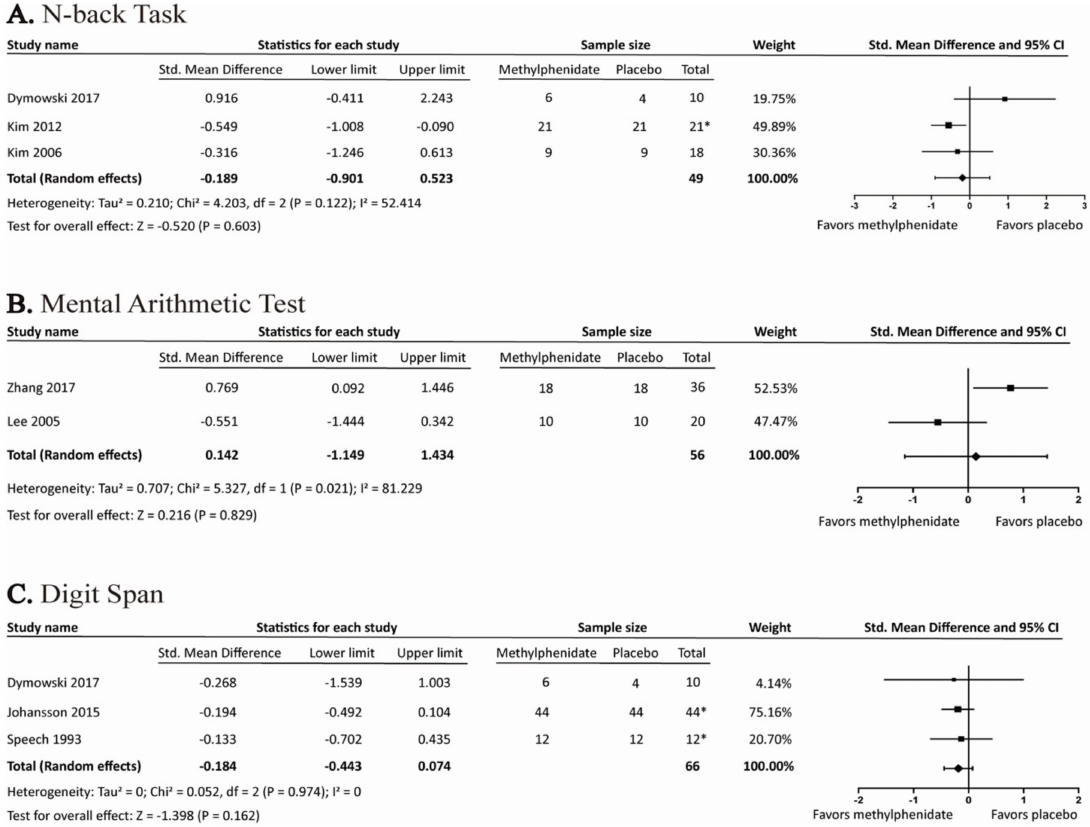
Figure 5. Forest plot of the e ff ects of methylphenidate on working-memory-related cognitive tests ( A ) N-back Task ( B ) Mental Arithmetic Test ( C ) Digit Span. *: crossover